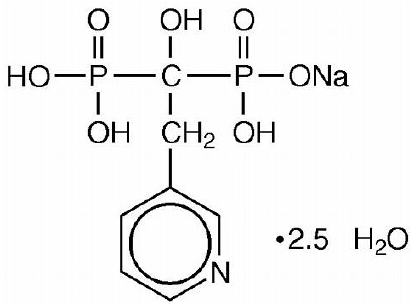
Figure 1. The structure of risedronate